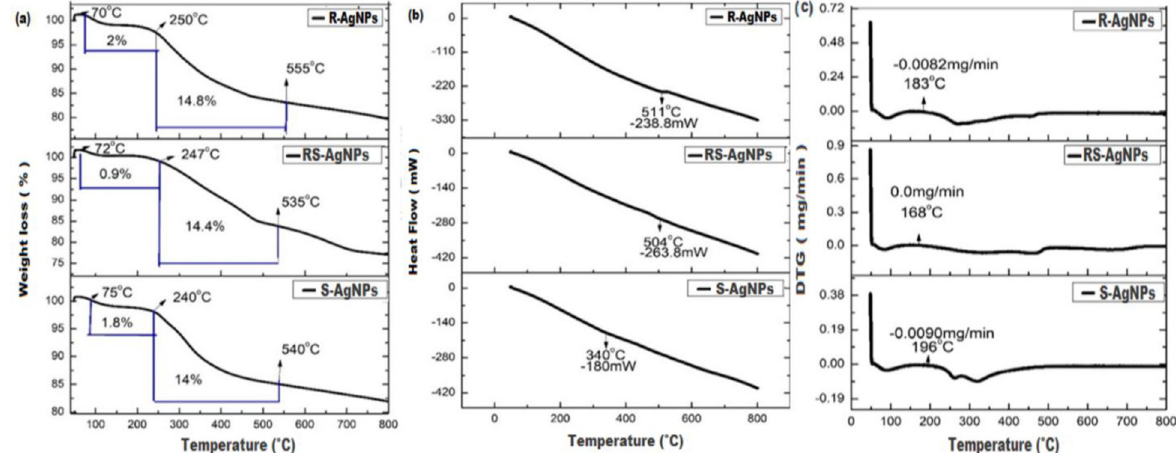
Fig 5. Thermogravimetric (TG) analysis (a) Differential scanning calorimetry (DSC) (b) and derivative thermogravimetric (DTG) curves (c) of R-AgNPs, S-AgNPs and RS-AgNPs.